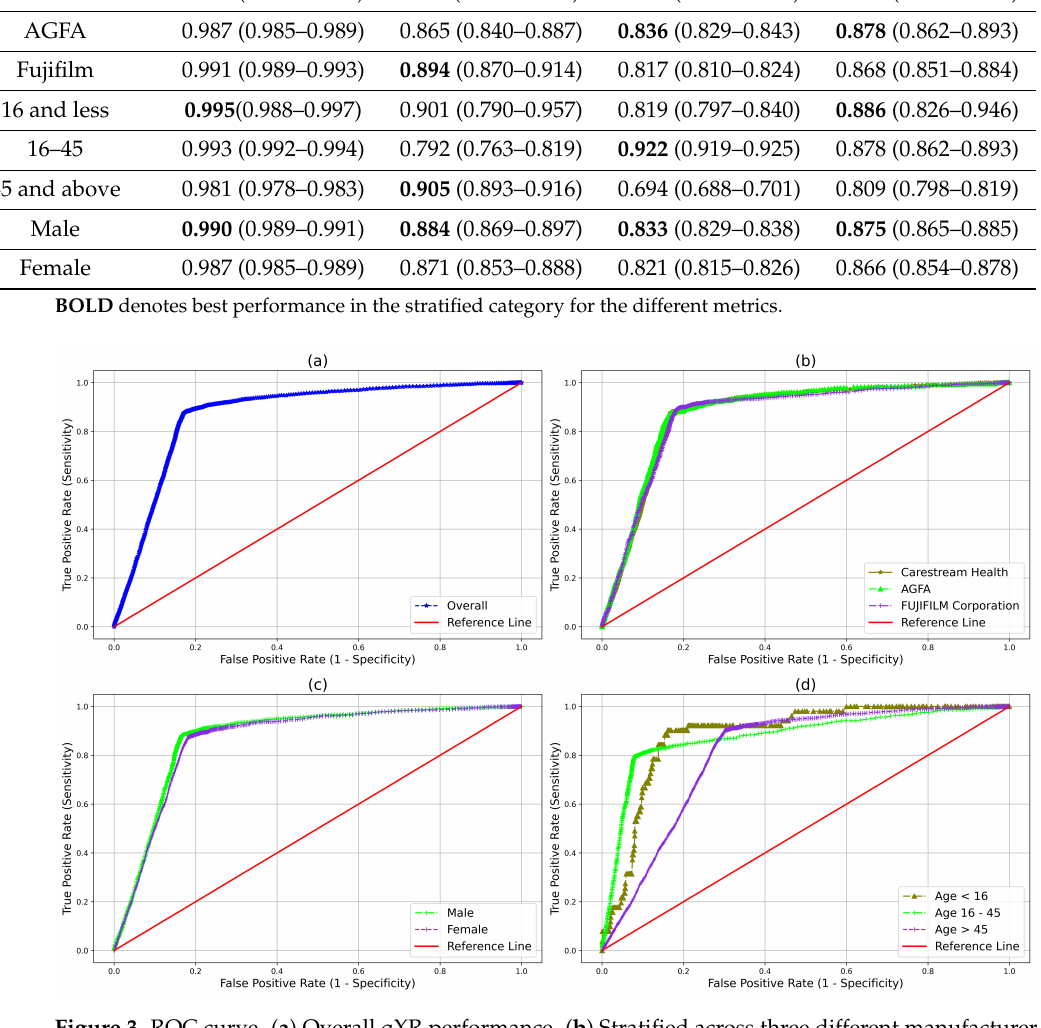
Figure 3. ROC curve. ( a ) Overall qXR performance. ( b ) Stratified across three different manufacturer subgroups. ( c ) Stratified across gender. ( d ) Stratified across 3 different age